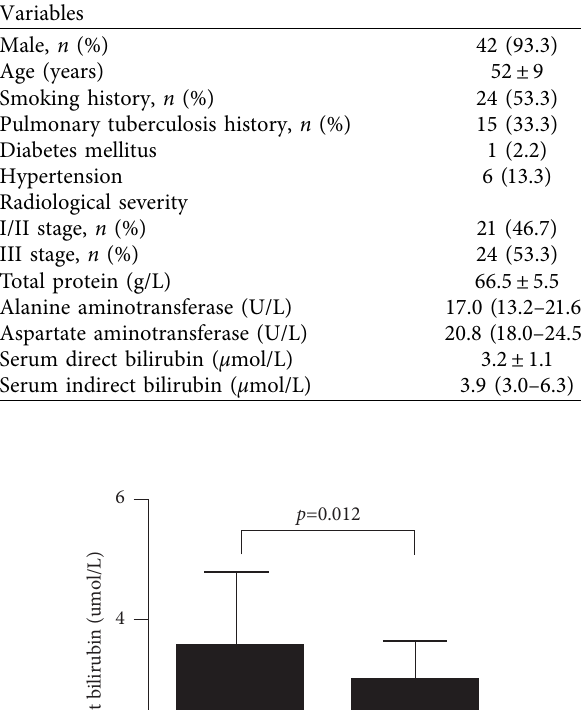
Table 1: Clinical and laboratory characteristics of the pneumo- coniosis patients.